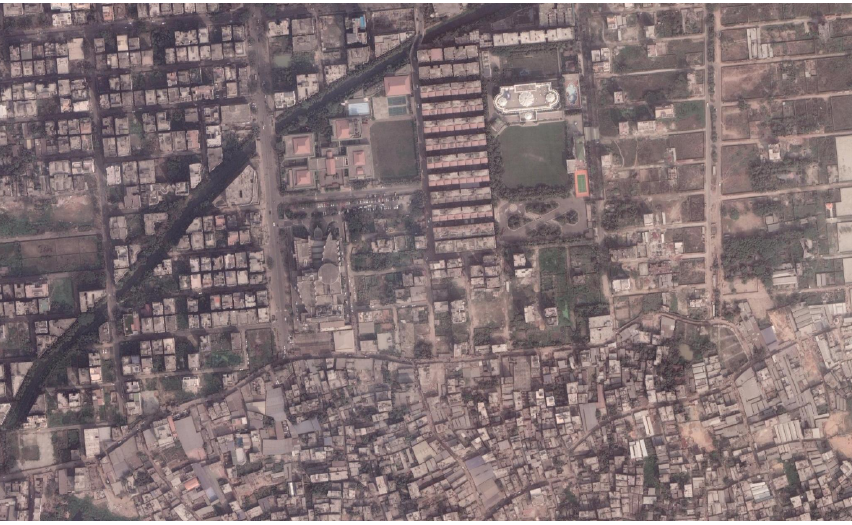
Figure 1. The morphological appearance of the urban environment in